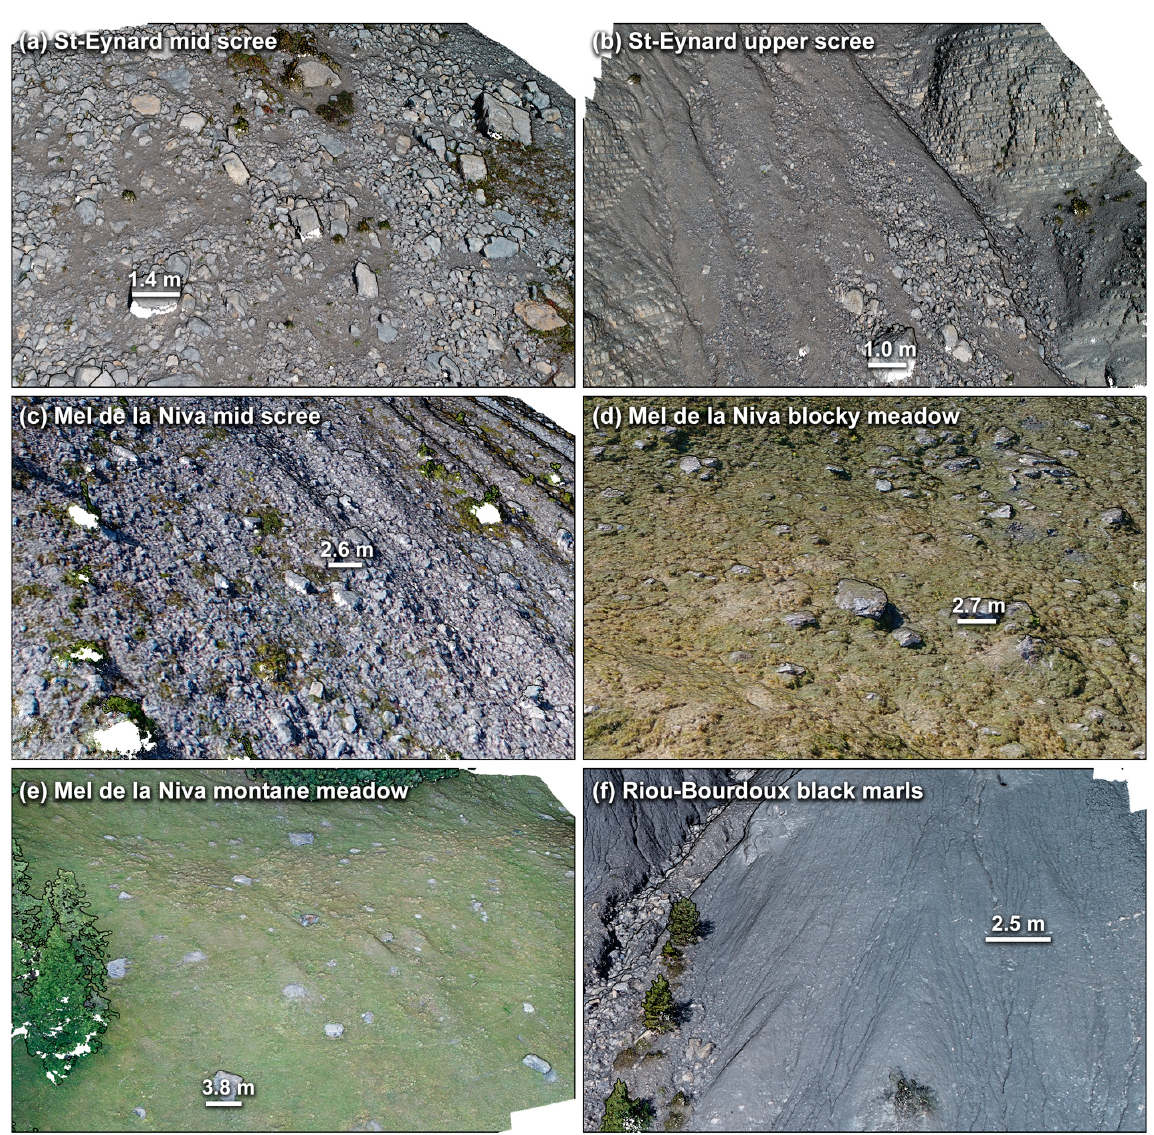
Figure 12. Six selected sites for their characteristic surface roughness encountered on rockfall-prone terrain. The central section of each 3D scene was isolated to extract its surface roughness. Here, each scene is shown with the 3D SfM model textured and with contours of the foreground elements highlighted using the Eye Dome Lighting filter.